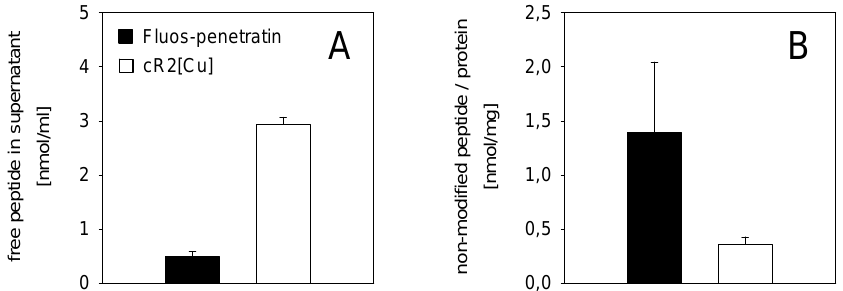
Figure 5. HPLC-based investigation of peptide uptake into HeLa S cells. ( A ) Amount of non-modified, free peptide in the supernatant after 1 h incubation at 37 °C with cR2[Cu] (18 nmol) and Fluos-penetratin (9 nmol), ( B ) non-modified peptide after extensive washing of cells and exposure to diazotized 2-nitroaniline. For each peptide, two independent experiments were performed in